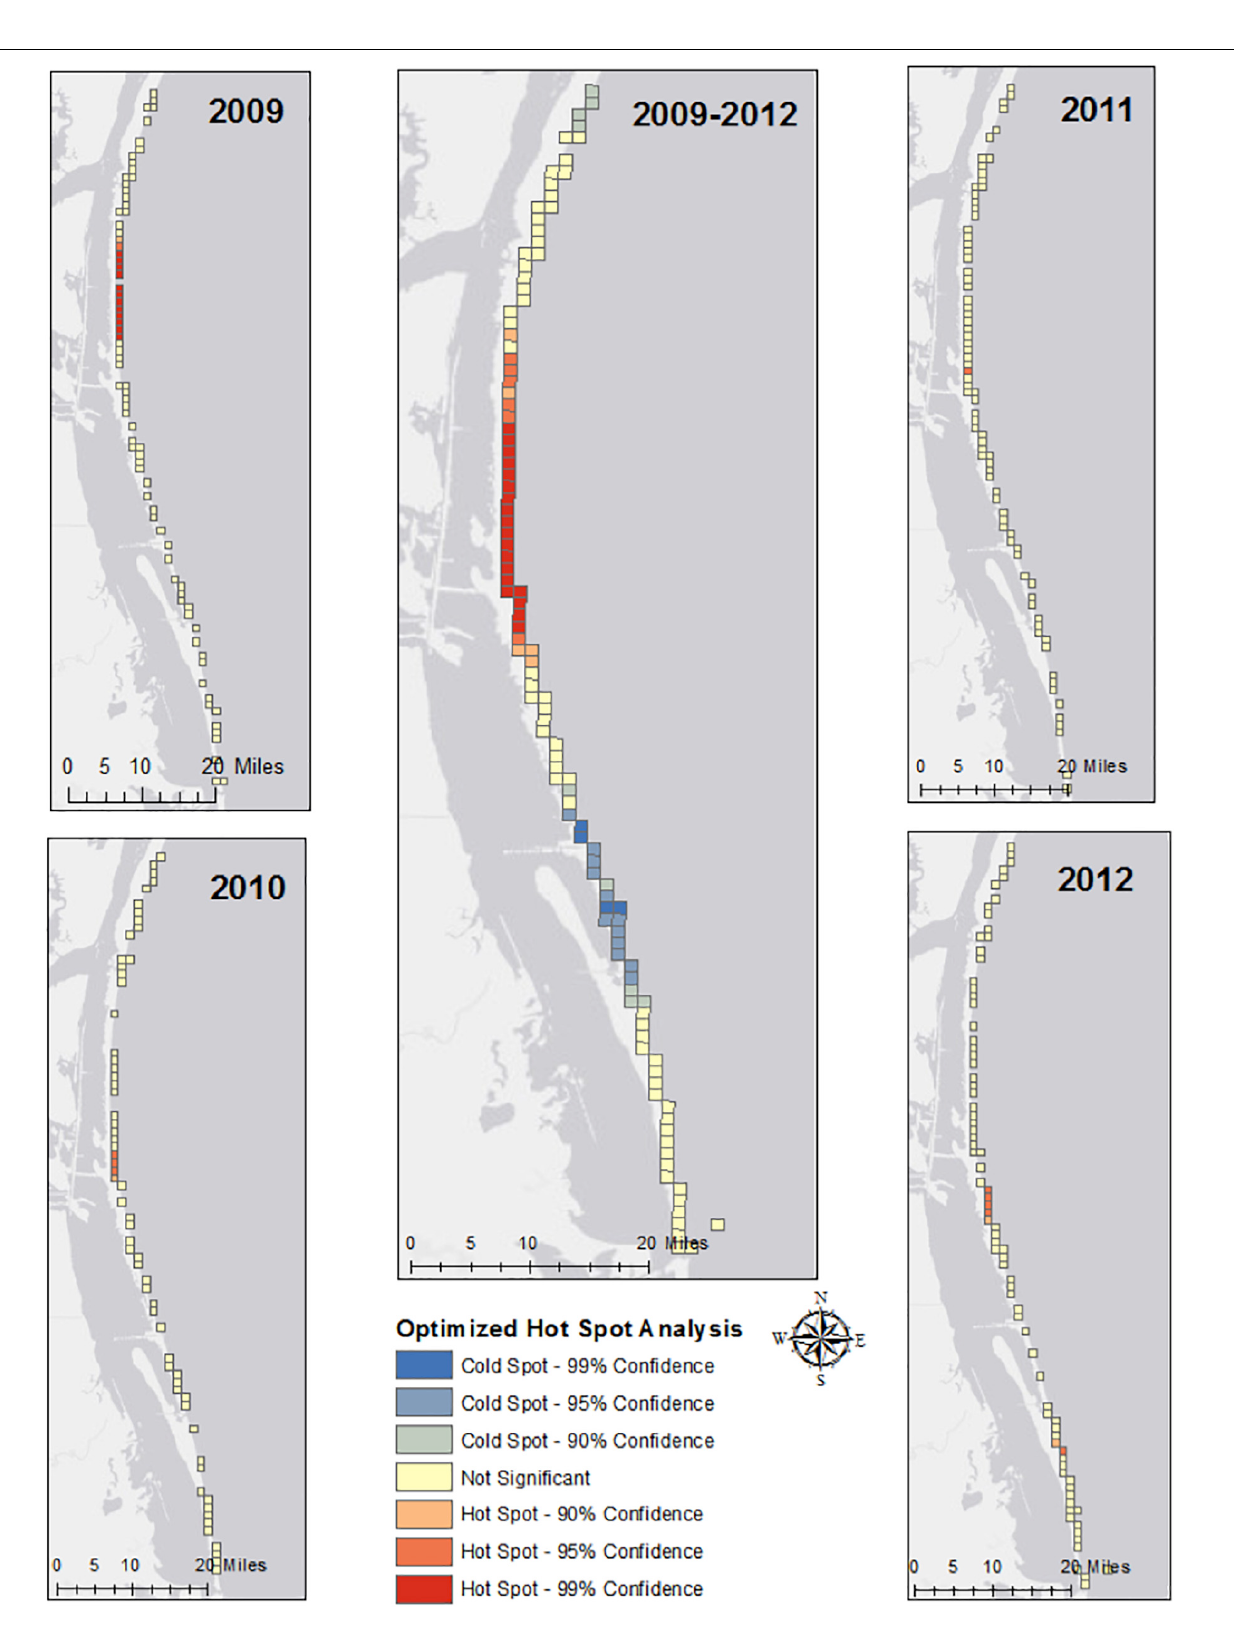
Frontiers in Marine Science |